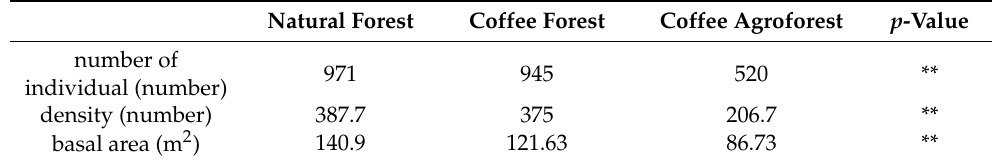
** = significant ( p < Table 5. Total number of individuals and basal area in 2.52 ha (63 plots) of the three forest types.